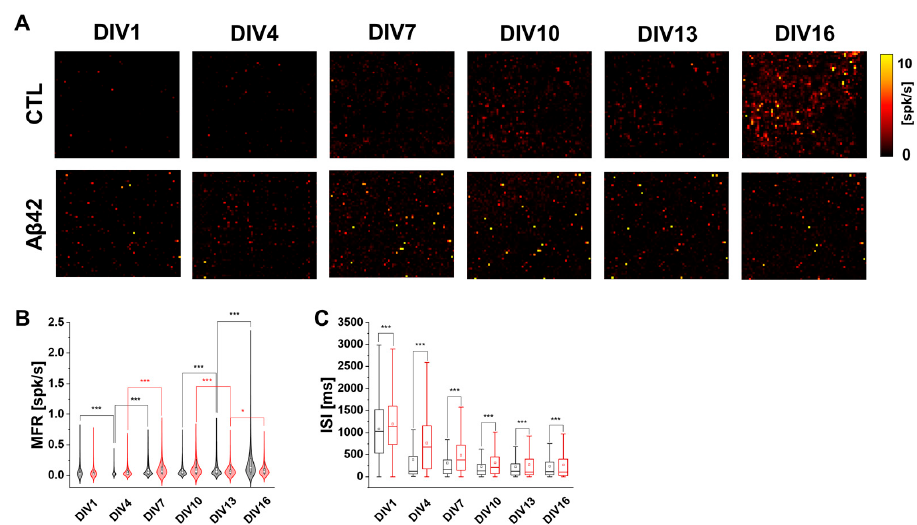
Figure 1. Spike activation property of developing neuronal cultures in HD MEA recording measurements. ( A ) MFR Activity map of spontaneous neuronal activation during 5 min recordings. Control (CTL) and A β 42 oligomer treatment groups in DIV1, 4, 7, 10, 13, and 16. The intensity scale ranges from 0 to 10 spikes per second. ( B ) Violin plot of mean firing rate (MFR) for 5 min recordings for control (black) and A β 42 (red) cultures during DIVs. The white dot represents the median and the thick white bar in the center represents the interquartile range. The thin black line represents the 1.5× interquartile range. ( C ) Box plot of interspike intervals (ISI) in milliseconds for 5 min recordings for control (black) and A β 42 (red) cultures during DIVs. The lower quartile as the borderline of the box nearest to zero expresses the 25th percentile, whereas the upper quartile as the borderline of the box farthest from zero indicates the 75th percentile. Error bars show SEM. *** p < 0.005, * p < 0.05; unpaired, two-tailed t -test with Welch’s correction.